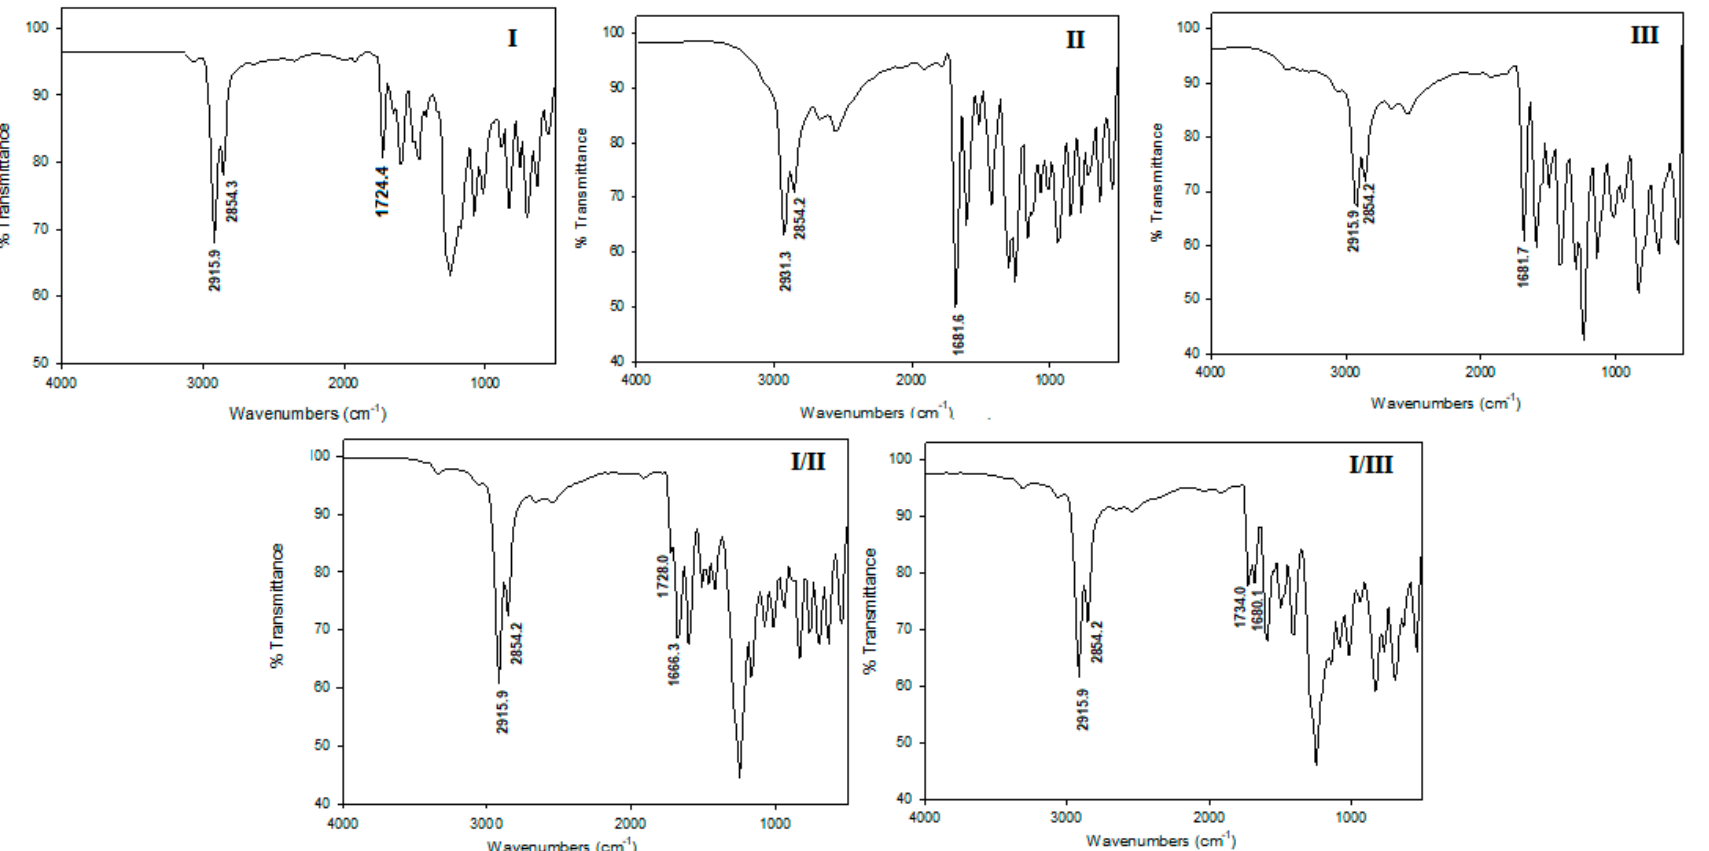
Figure 1. FT-IR spectrum of azopyridine base I , acids II and III , as well as their 1:1 supramolecular H-bonded complex I/II and I/III.